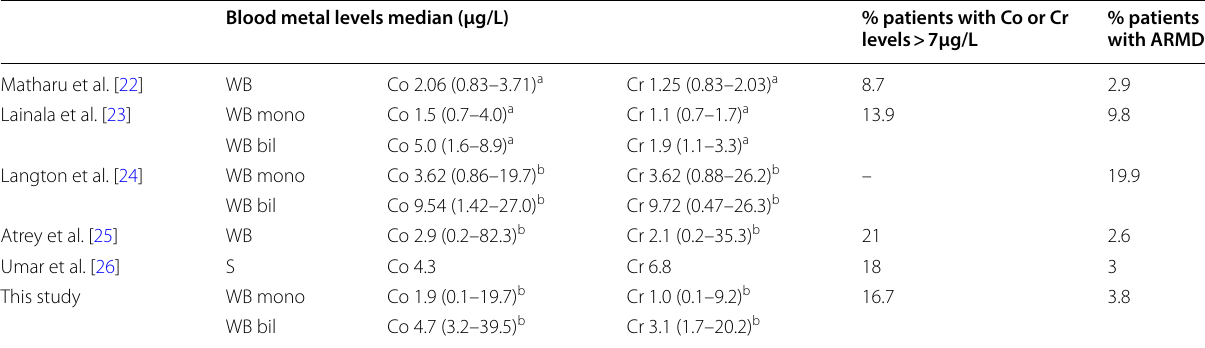
WB whole blood, S serum; mono monolateral MoM, bil bilateral MoM a Interquartile range b Range